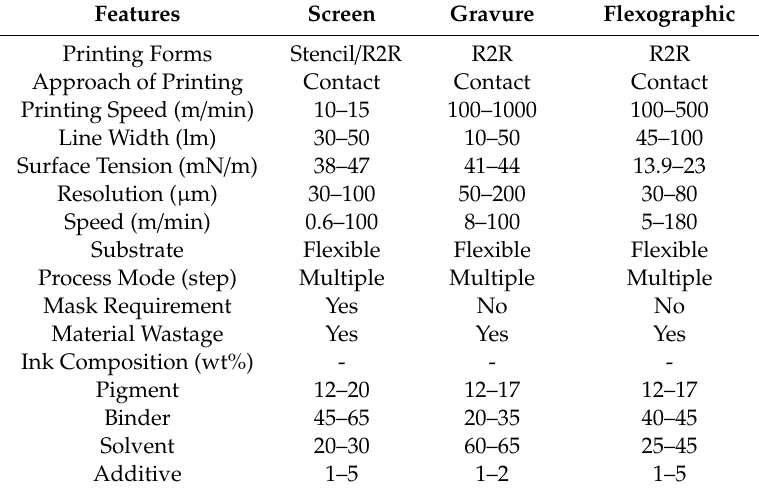
Table 5. Comparison of di ff erent printing methods